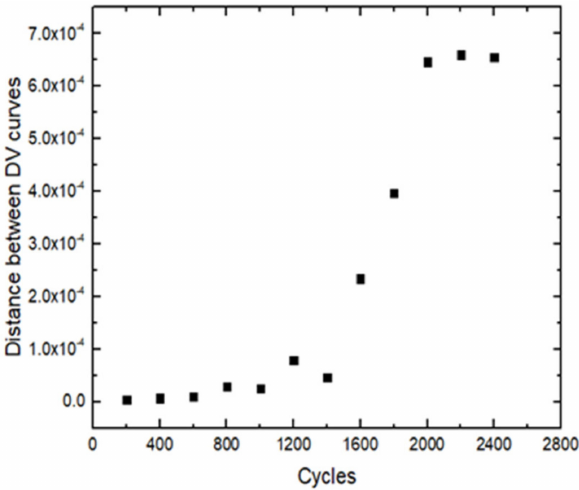
Figure 4. The distance between DV curves number of cycles.